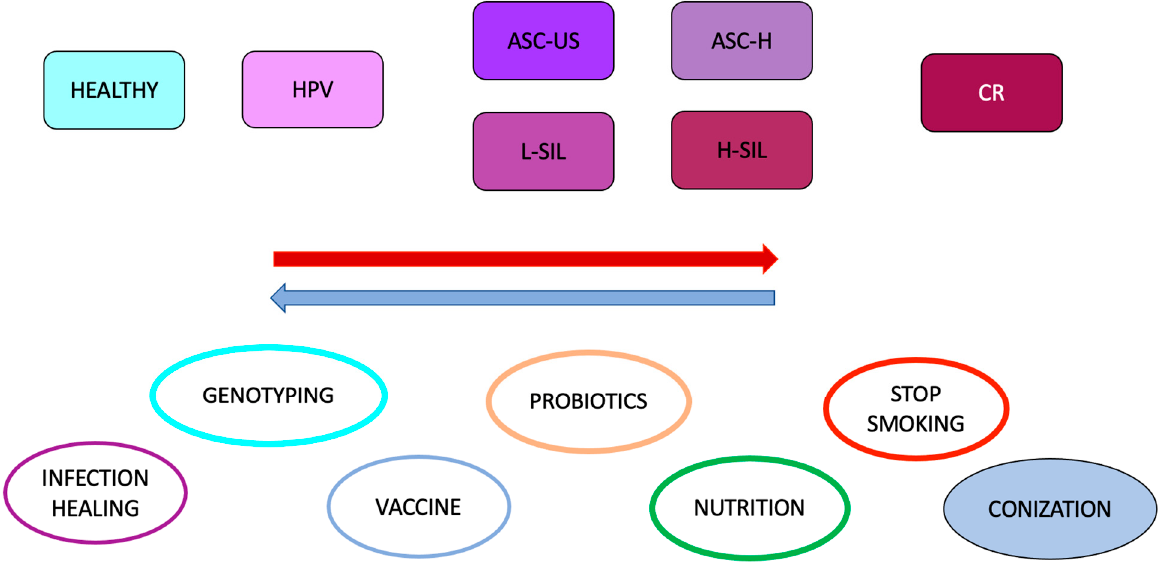
Figure 4. Example image of the tools currently available to counteract the pathogenesis of HPV-related infection (ASC-US: atypical squamous cells of undetermined significance, ASC-H: atypical squamous cells cannot exclude H-SIL, L-SIL: low-grade squamous intraepithelial lesions, H-SIL: high-grade squamous intraepithelial lesions, CR: cervical carcinoma).